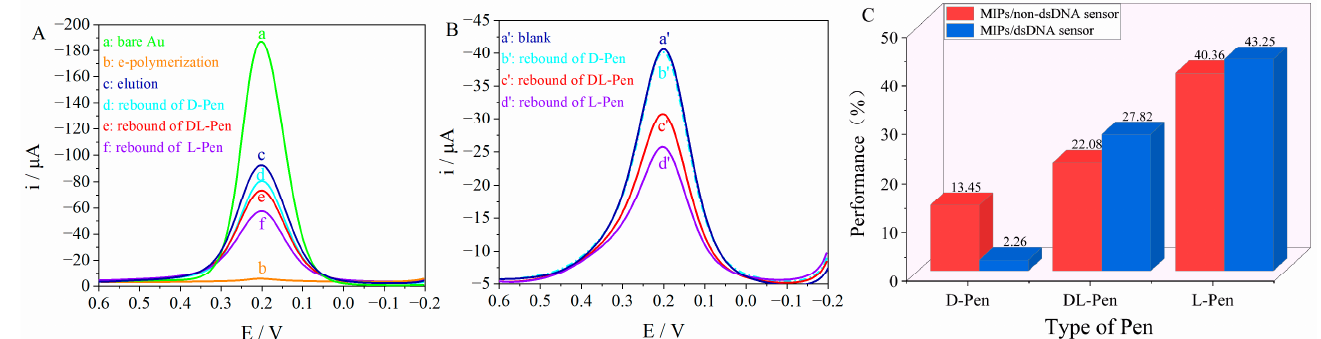
Figure 5. The DPV responses of MIPs/non-dsDNA sensor ( A ) and MIPs/dsDNA sensor ( B ) on 5.0 × 10 − 14 mol/L of Penicillamine enantiomers in 0.005 mol/L of K 4 [Fe(CN) 6 ]/K 3 [Fe(CN) 6 ] (contain 0.1 mol/L KCl) solution over a potential range from +0.6 V to − 0.2 V, with a scan rate of 50 mV/s and pulse amplitude of 50 mV; the recognition performance ( C ) of MIPs/dsDNA sensor and MIPs/non-dsDNA sensor for Pen enantiomers.